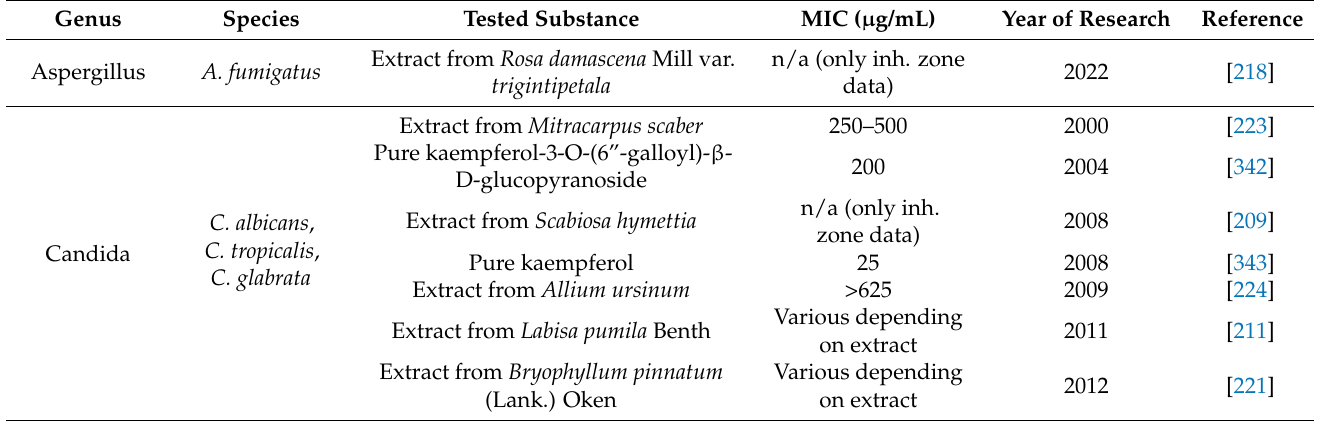
Table 4. Kaempferol-containing extracts and compounds with a verified antifungal